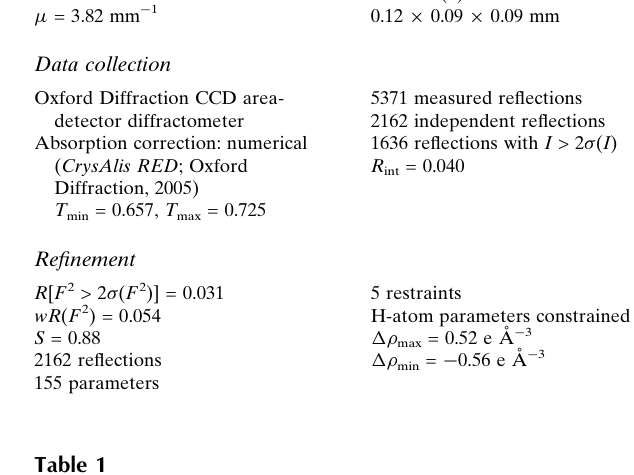
Selected geometric parameters (A˚ , (cid:4) ).